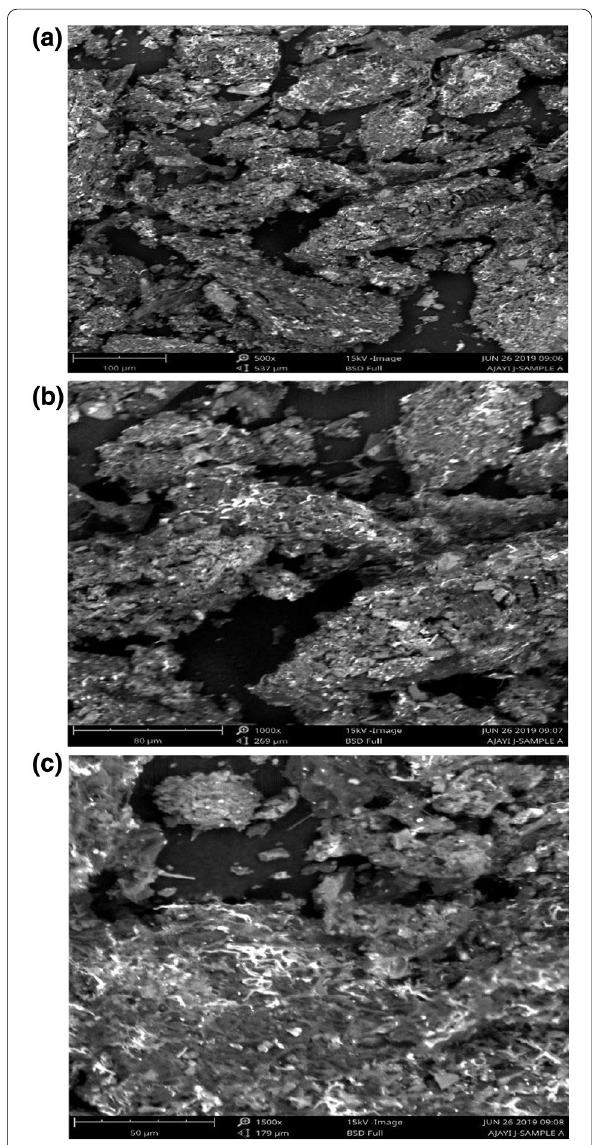
Fig. 2 a SEM picture of M. charantia silver nanoparticles at magnification of 100 µm. b SEM picture of M. charantia silver